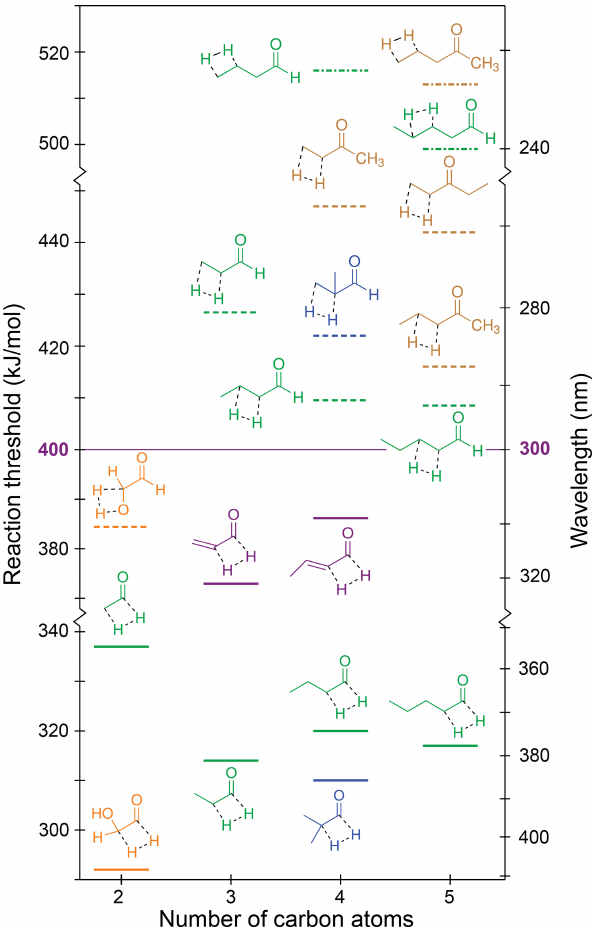
Figure 7. Zero-point vibrational-energy-corrected B2GP-PLYP- D3/def2-TZVP S 0 H 2 -loss thresholds. Solid lines: formyl H + α -H; dashed lines: α -H + β -H; dot-dashed lines: β -H + γ